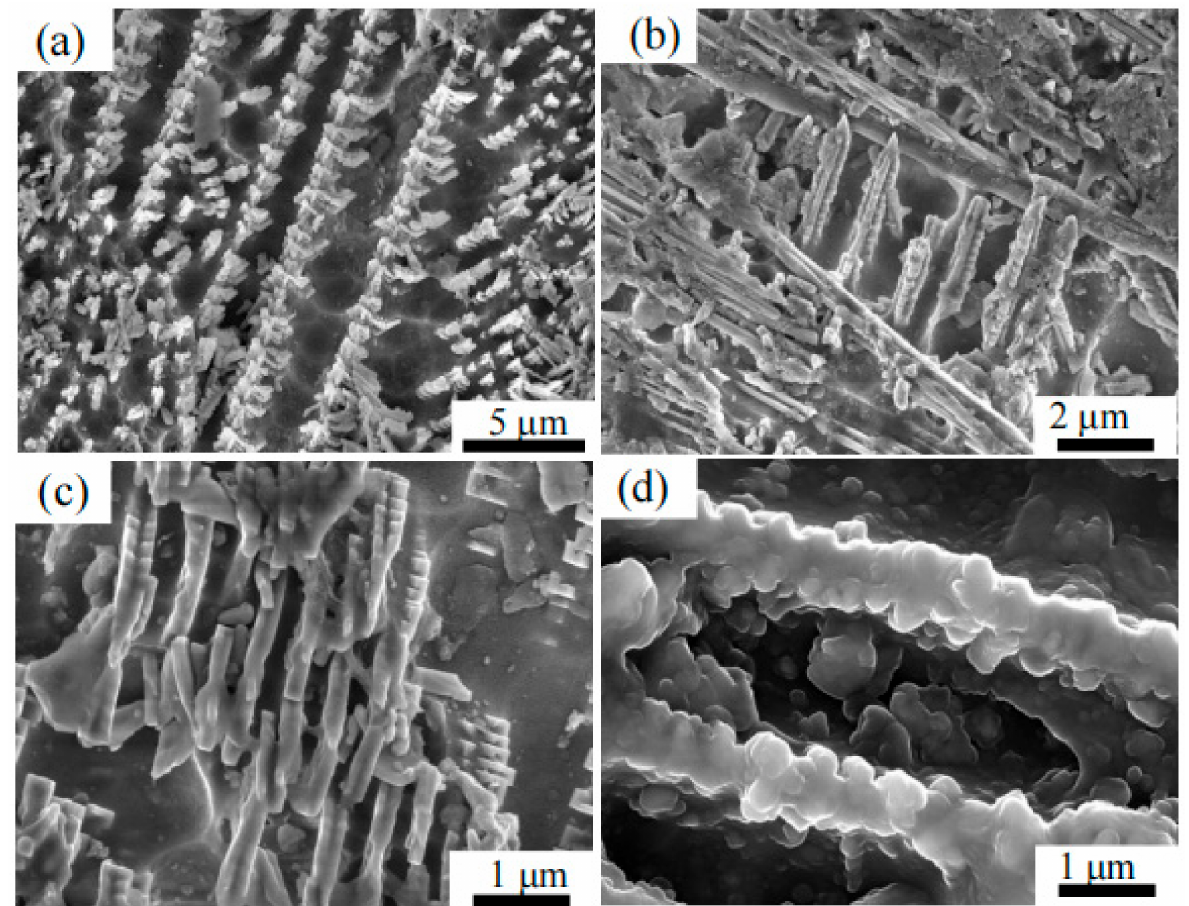
Figure 9. Secondary electron image of crystals on the glaze surface: ( a ) dendritic-like crystals and ( b – d ) magnified view of parts in ( a